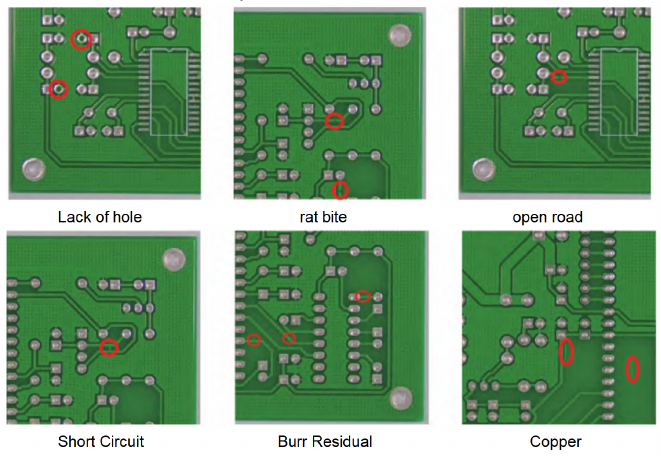
Figure 8. Visualization of images of six types of defects in PCB boards, and the red box represents the defective